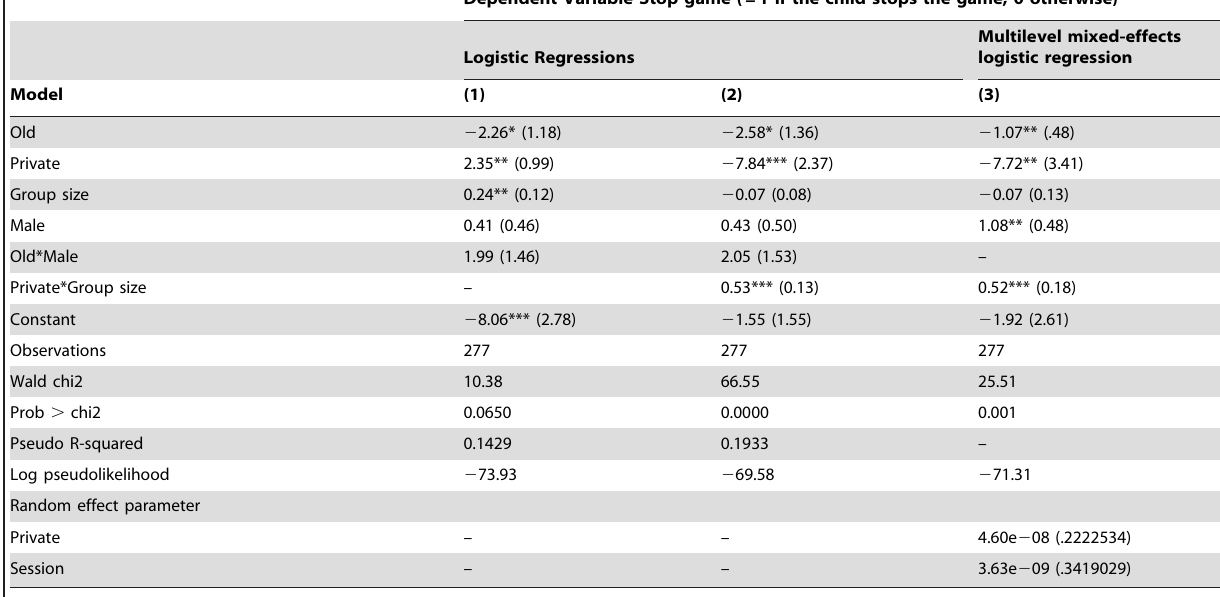
Table 3. Decision to stop the